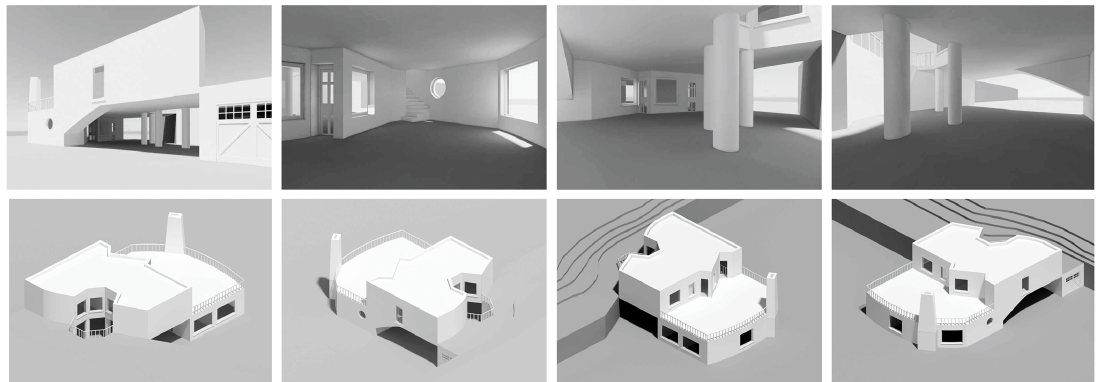
Figure 15. House 13. Axonometric views and perspectives (C.